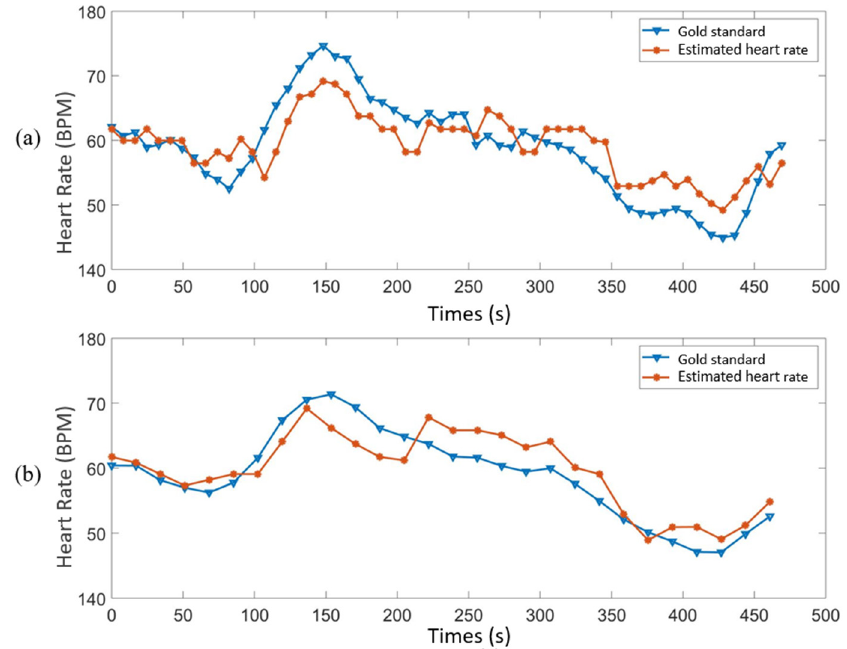
Figure 6. The comparison between gold standard and monitoring results from the skin surface of the abdomen of the resting pig: ( a ) window size 68.27 s; ( b ) window size 34.14 s.